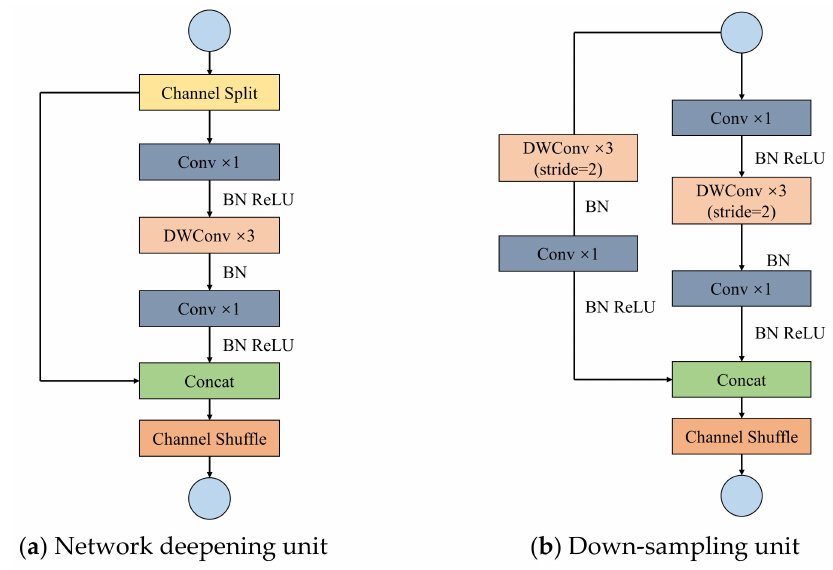
Figure 5. Two types of block unit for